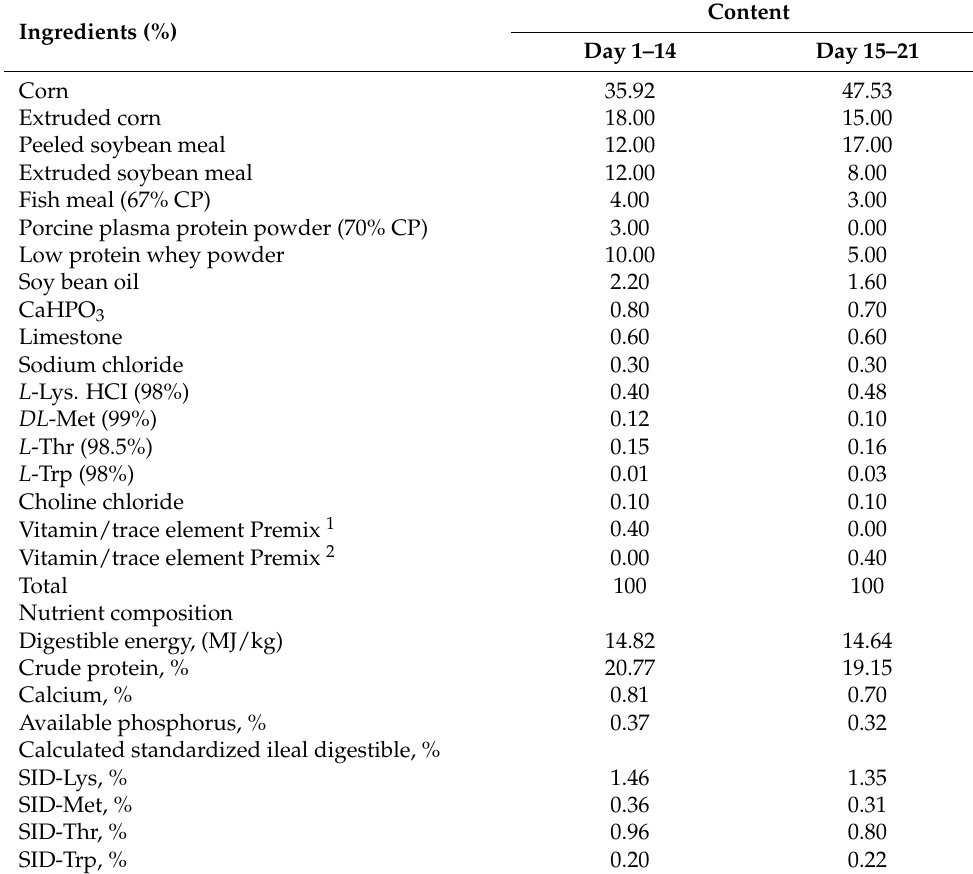
Table 1. Composition and nutrient levels of basal diet (air-dry